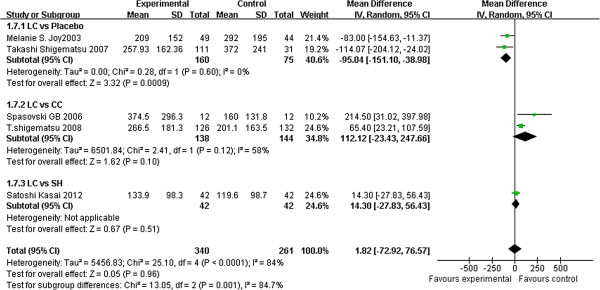
Forest plot of iPTH in patients treated with LC and control therapy. Studies were identified by name of the first author and year of publication. Mean differences (MDs) were pooled using the random-effect model and shown on a scale of −500 to 500.